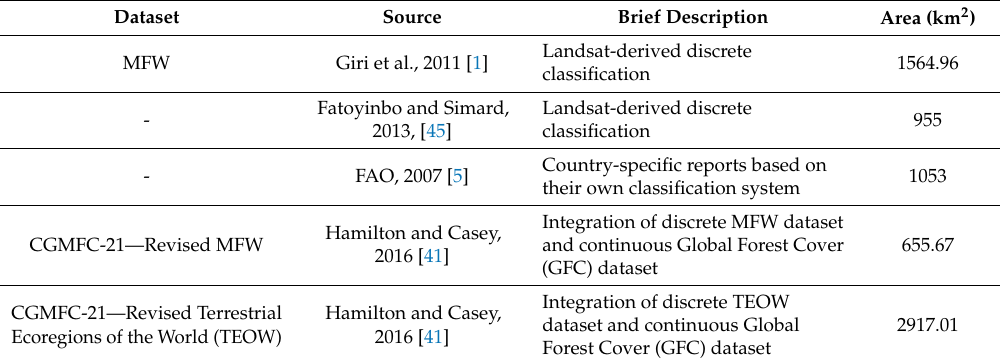
Table 1. Comparison of mangrove extents in Sierra Leone for 2000 as estimated by the Mangrove Forests of the World (MFW), and the continuous mangrove forest cover for the 21st century